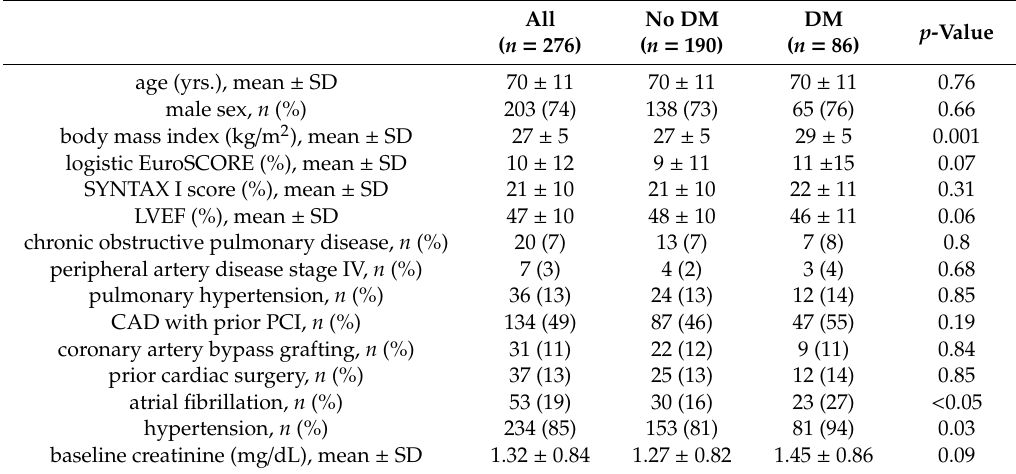
Table 1. Baseline Characteristics.